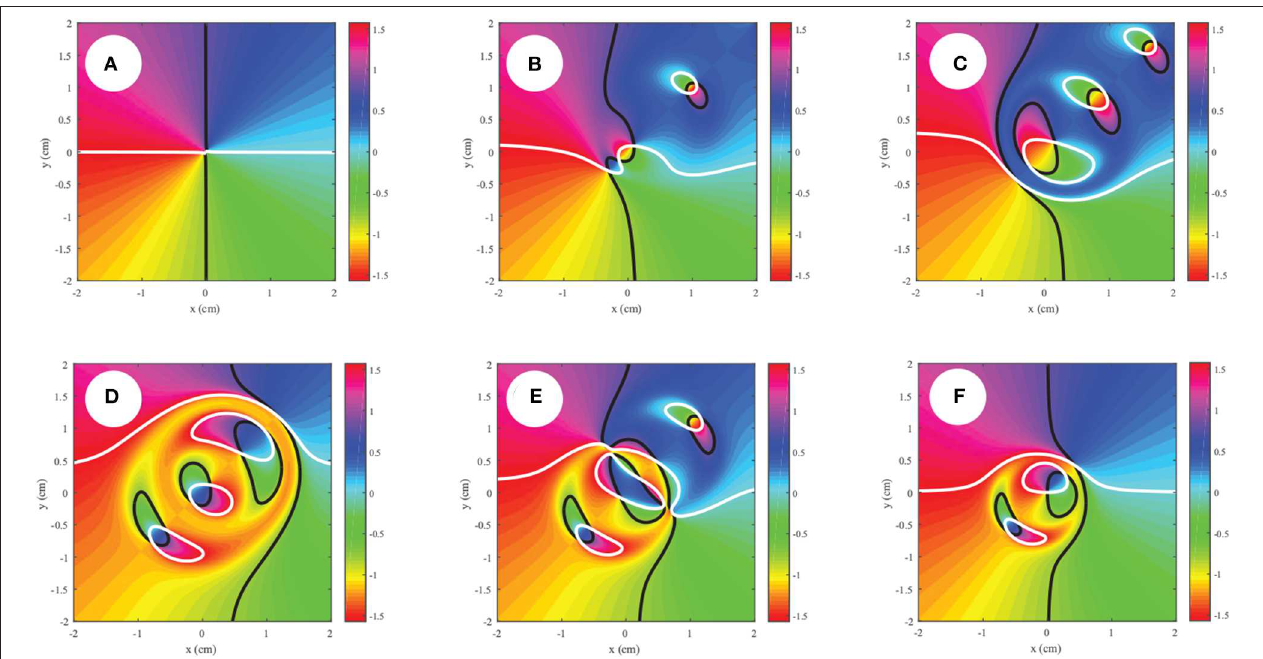
FIGURE 7 | Behavior of a partially coherent polarization singularity as the spatial coherence is decreased, with (A,D) δ Here t R 2, t L 1 and the observation point is taken at r 1 = = perpendicular in (D–F)